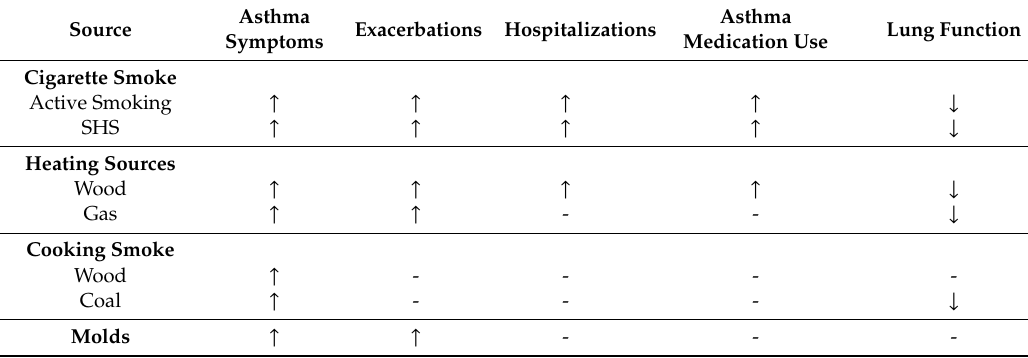
Table 2. E ff ects of indoor pollution on asthma according to their